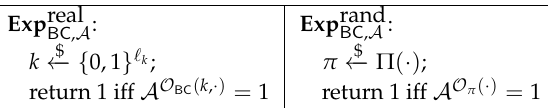
Figure 2. Experiments for the block cipher.